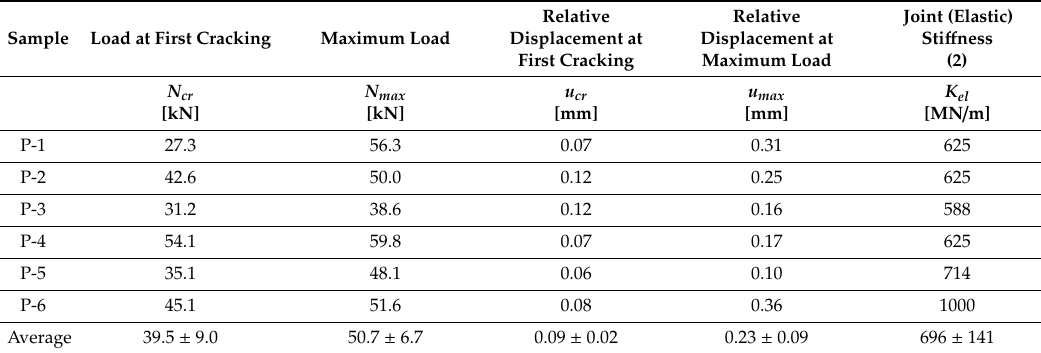
Figure 3. Experimental load-displacement responses for the tested specimens P1–P6: ( a ) full range of relative displacement; ( b ) range of relative displacement up to 1.0 mm. Table 1. Experimental results for the tested specimens [13].